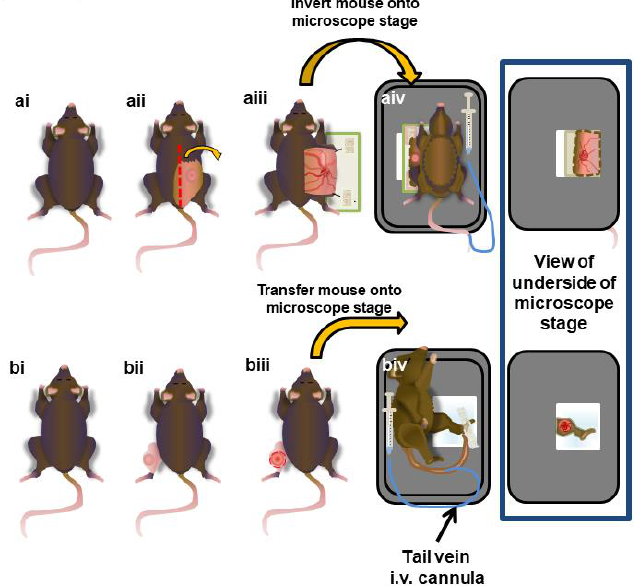
Figure 1. Surgical preparation of subcutaneous and intramuscular tumors for intravital microscopy (IVM) imaging. The mice were injected with tumor cells either subcutaneously on their flank ( a ) or intramuscularly in the gastrocnemius of the leg ( b ). After approximately 10 days, the tumors were exposed ( aii , bii ), tissue movement was surgically stabilized ( aiii , biii ), and the mouse was inverted and placed onto a heated (37 °C) microscope stage ( aiv , biv ). An i.v. cannula was inserted into the tail vein to provide anesthetic when necessary throughout the imaging procedure.